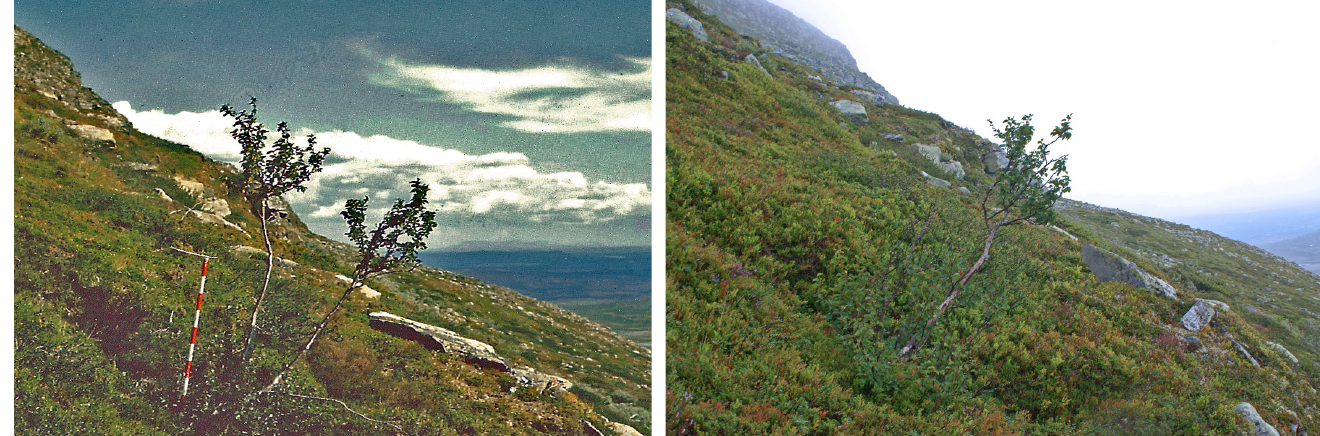
Figure 8: Left. The treeline of birch by the mid-1970s (1115 m a.s.l.), when it had advanced by 160 m since 1915. Right. Ty- pically for the situation in continental areas after 1975, stem mortality is unbalanced and there is virtually no individual size increment. Mt. Brattriet. 22 August